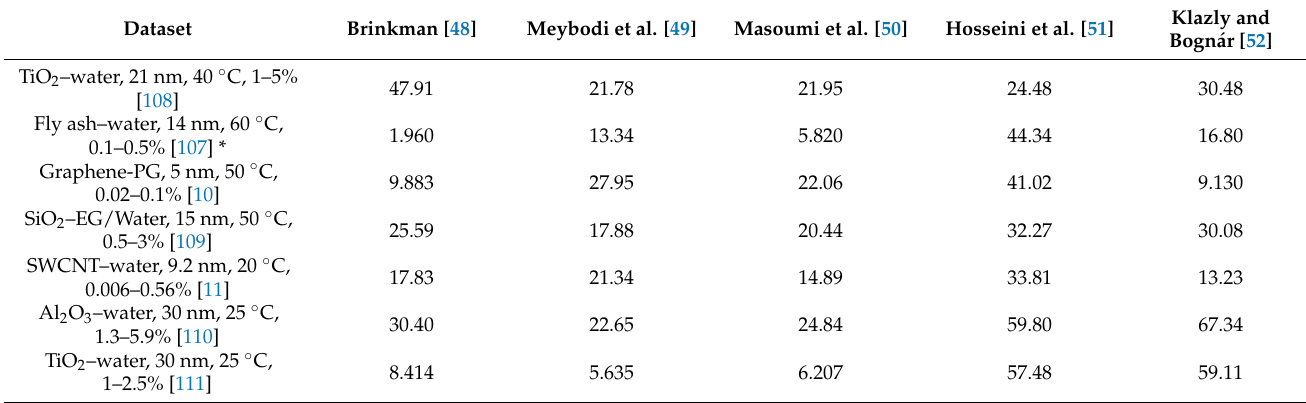
Table 8. Level of accuracy (%) of each nanofluid viscosity model when compared against given experimental data.